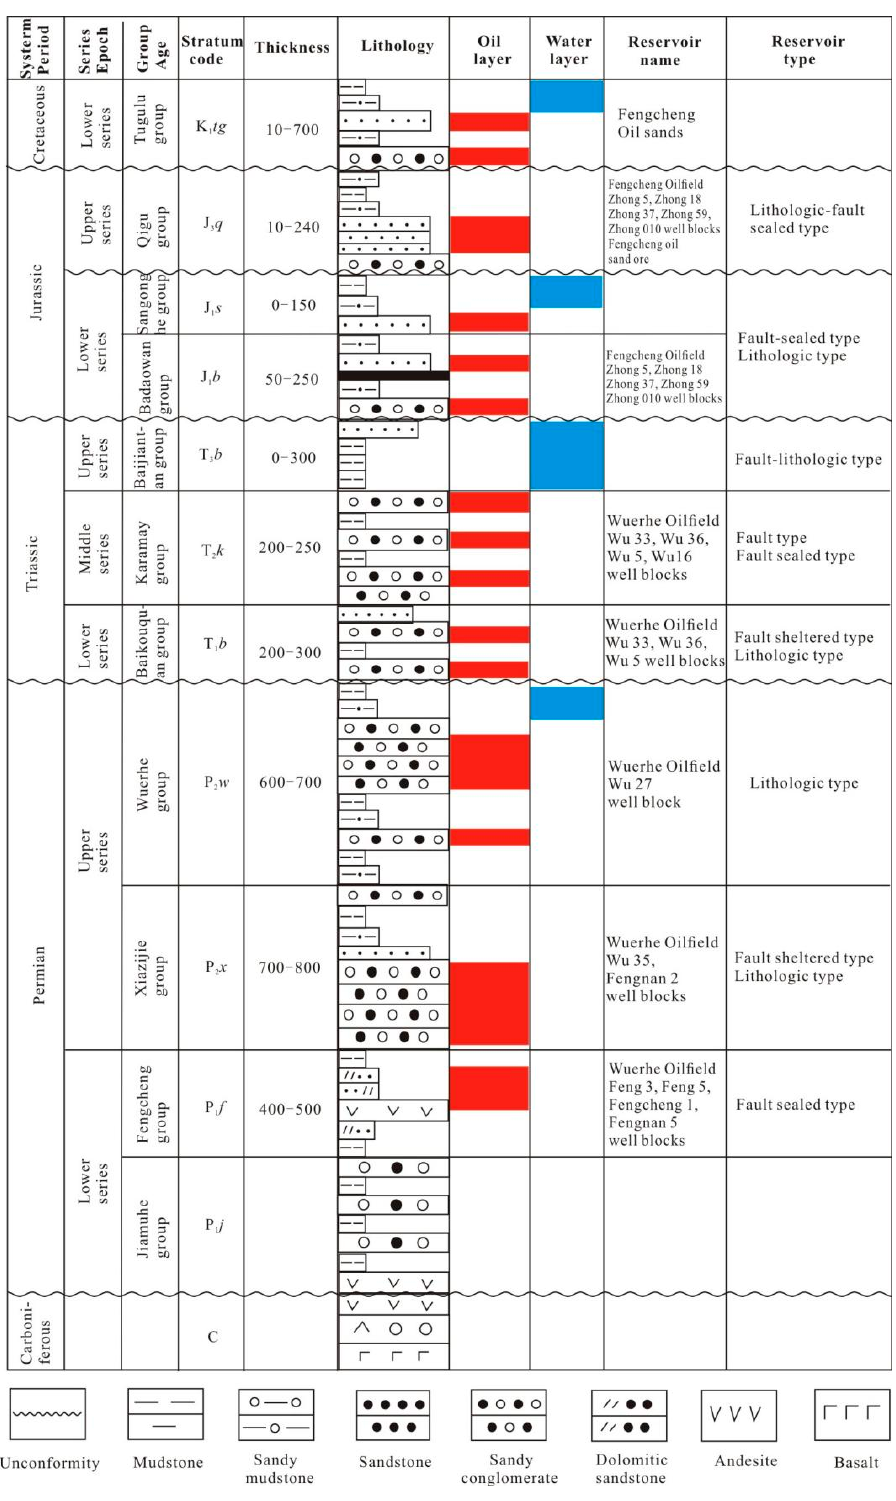
Figure 2. Comprehensive stratigraphic column of Wuerhe area, showing the stratigraphic condi-